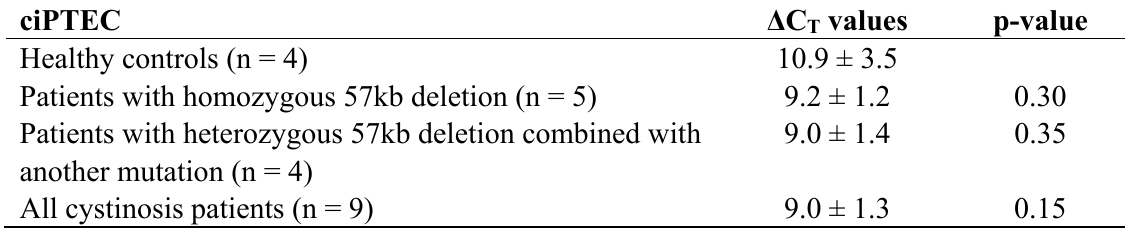
Figure 1. Expression of P-gp (150–170 kDa)) and GAPDH (36 kDa) in membrane vesicles of control and cystinotic ciPTEC and total kidney homogenate (HuKid). Representative blot of two independent measurements is